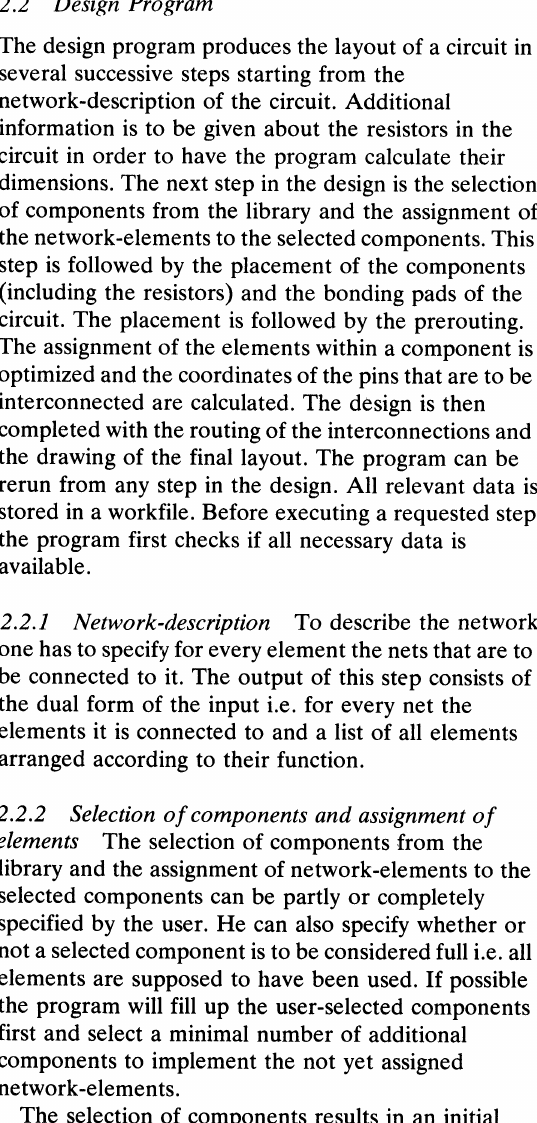
a) Symbolic rectangular representation of a DM7400; b) the corresponding component